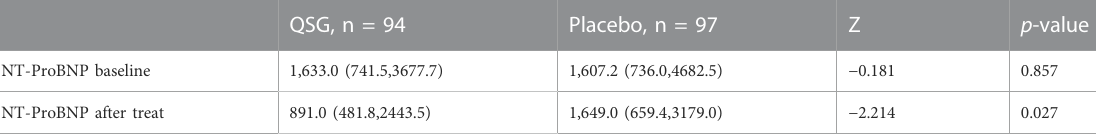
TABLE 3 numerical value change in NT-proBNP.